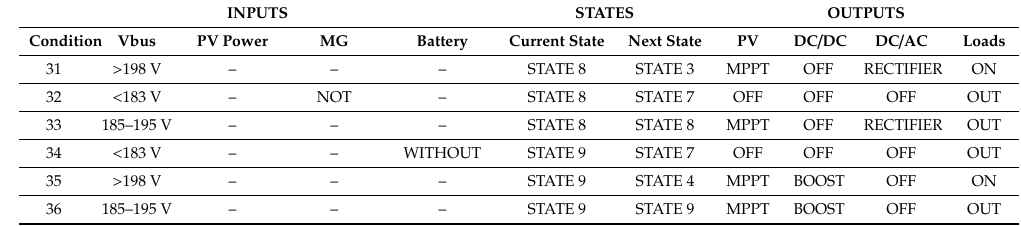
Table 7. GMC transitions in STATE 8 and